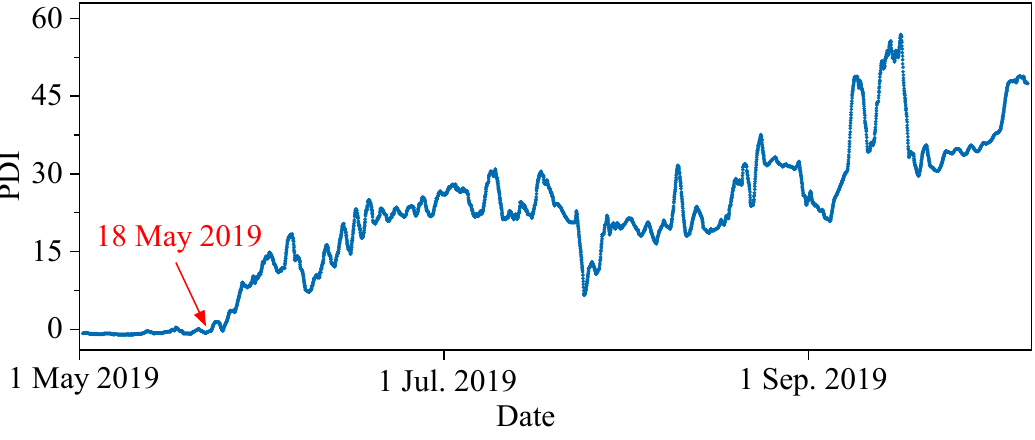
Figure 14. PDI curve of the FTU.